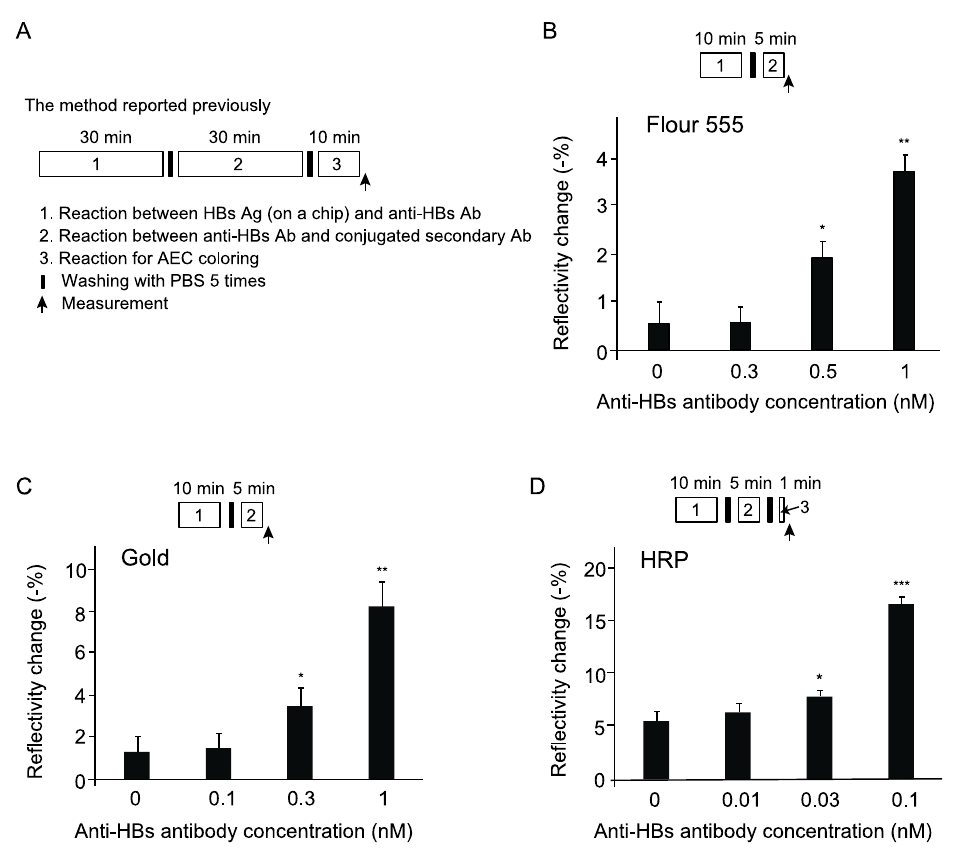
Figure 2. Comparison of signal enhancement methods in detection of anti-HBs antibody with a WM sensor. ( A ) Experimental procedure of the previous method using a peroxidase reaction [10]. Ag, antigen. Ab, antibody. ( B ) Signal enhancement using secondary antibody conjugated with the fluorescent dye (Fluor 555). ( C ) Signal enhancement using gold nanoparticle-conjugated secondary antibody. ( D ) Time shortened method using HRP-conjugated secondary antibody. * p < 0.05, ** p < 0.01, *** p < 0.001 versus control sample without anti-HBs antibody (n = 3 for each group).